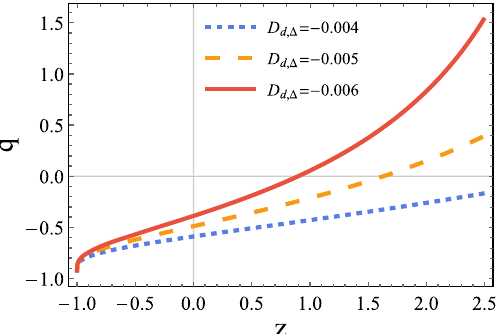
is currently accelerating. Finally, notice the change of sign, meaning that the subdominant term in the horizon entropy is capable of explaining both decelerated and accelerated expansions. Unlike Λ CDM in which q approaches 0 . 5 when z goes to infinity, q grows without restriction for the early universe in this model. Then, one should restrict the present analysis to the late-time and close-future universe.